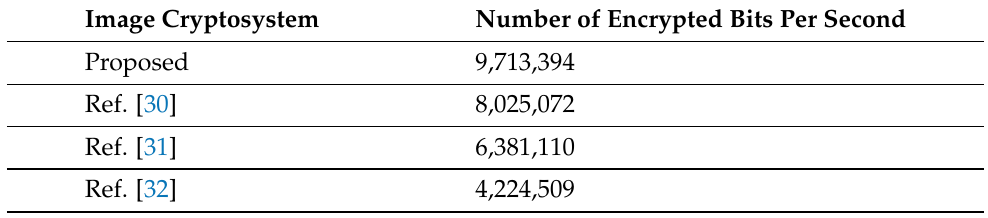
Table 1. Comparison of time encryption for the presented cryptosystem with other related cryptosys- tems, as reported in